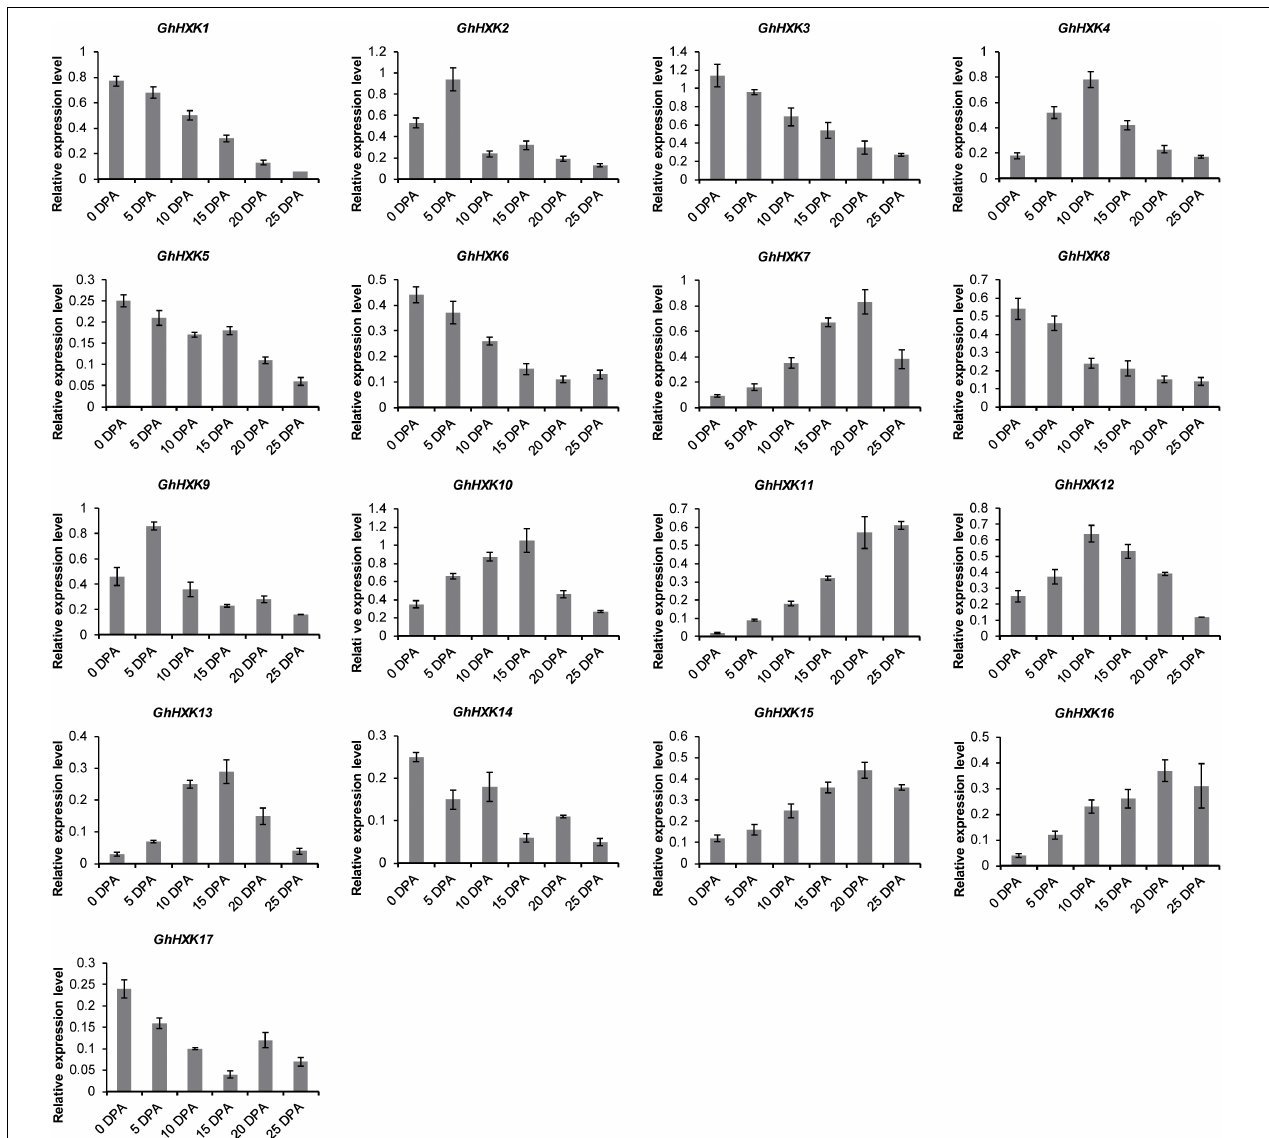
FIGURE 9 | The expression levels of GhHXKs during fiber developmental stages (0, 5, 10, 15, 20, and 25 DPA) analyzed by qRT-PCR. Error bars represent means ± SE from three independent biological repetition. The relative expression level was calculated by using GhUBQ7 as the internal